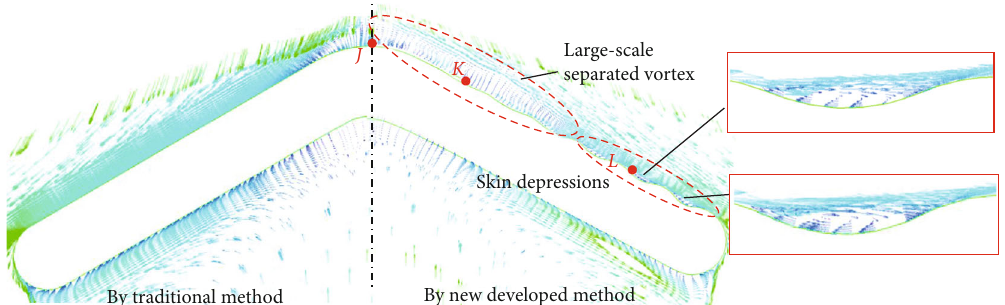
By traditional method Figure 14: Comparison of fl ow detail near